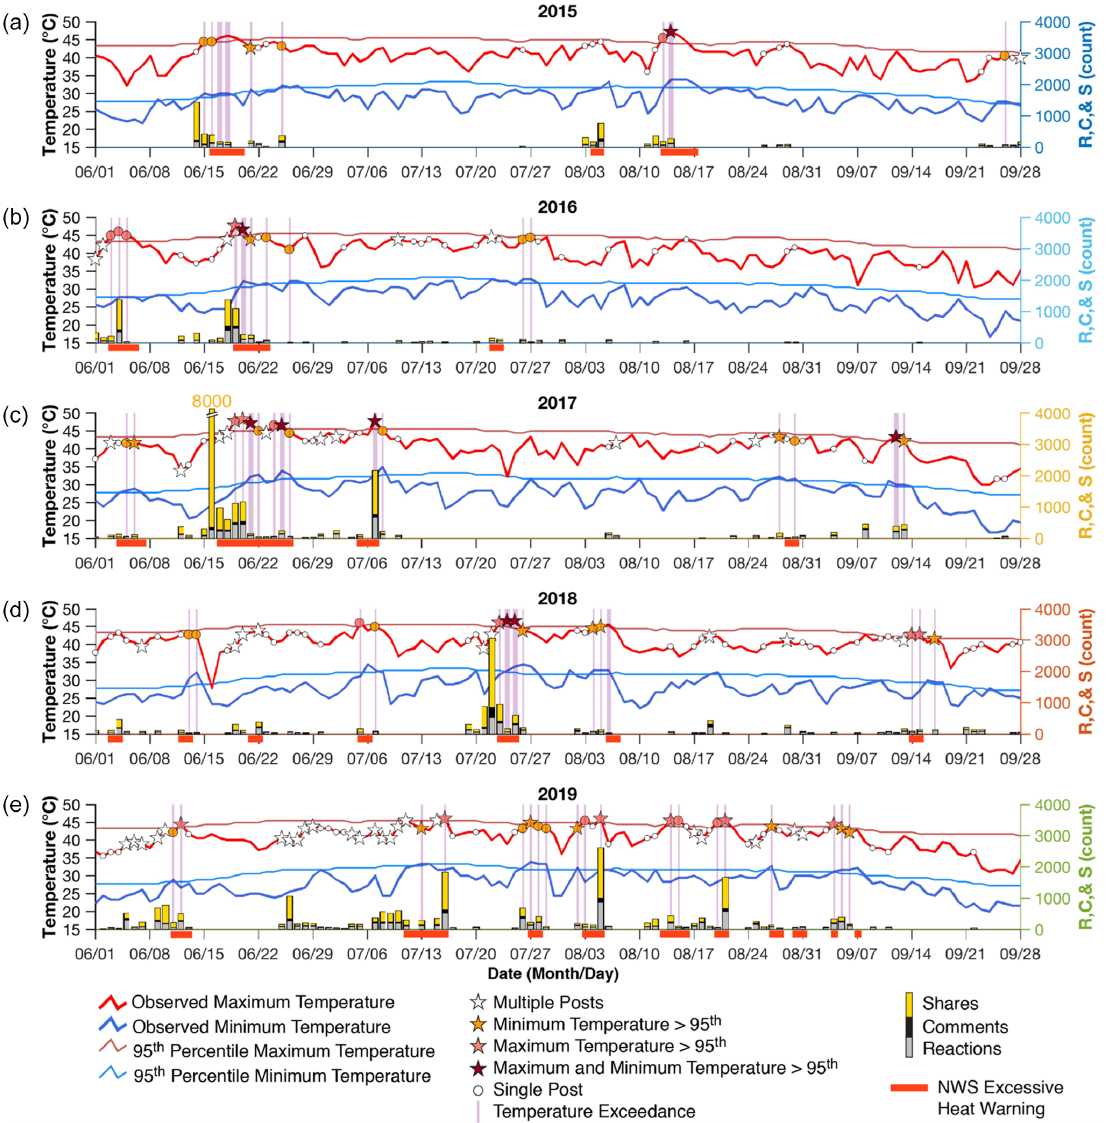
Figure 2. Phoenix Airport temperatures (left y axis) and Facebook engagement (right y axis), with reactions (R), comments (C), and shares (S) for the NWS Phoenix spanning the June–September periods for (a) 2015, (b) 2016, (c) 2017, (d) 2018, and (e) 2019. Excessive heat warnings are shown by red bars along the x